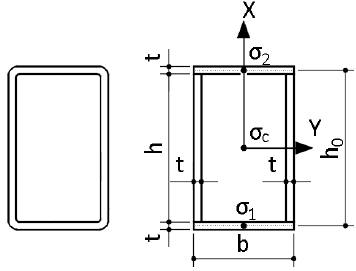
Figure 6. Column section scheme.